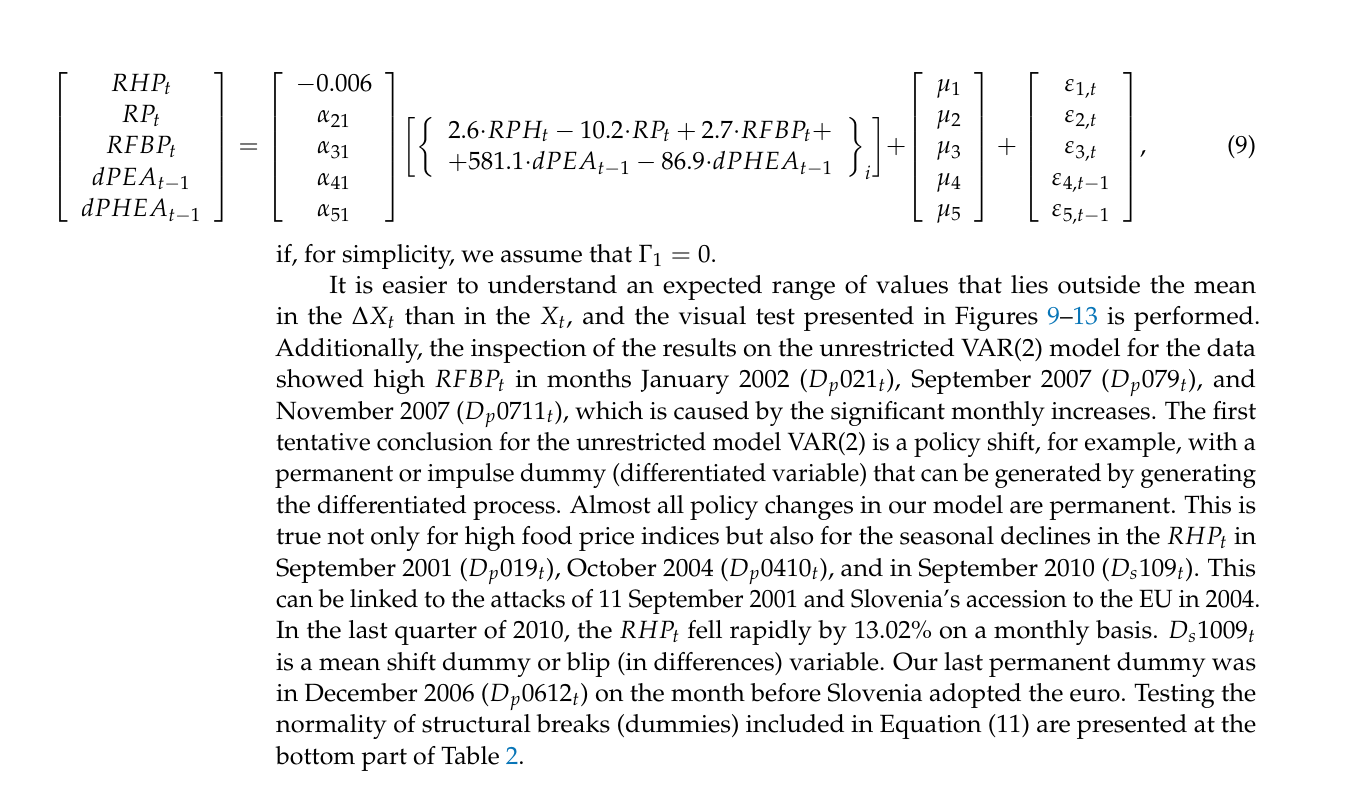
Table 2. Misspecification test of real price